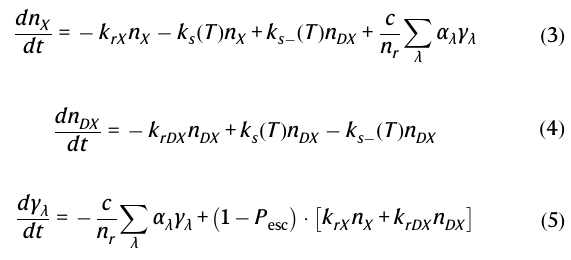
Fig. 3 | Temperature-dependent behavior of excitonic species in the thin fi lm. a 2D perovskite thin fi lm photoluminescence (PL) spectra as a function of tem- perature revealing, beyond the primary PL peak, the emergence of secondary and tertiaryPLpeaksassignedto b thebrightexciton(X),thedarkexciton(DX),andthe biexciton (XX) with PL shown in red and absorption in blue. c , d Time-resolved PL fortheun fi lteredbare2D fi lmspectrum(black),X fi ltered spectrum(blue),andDX